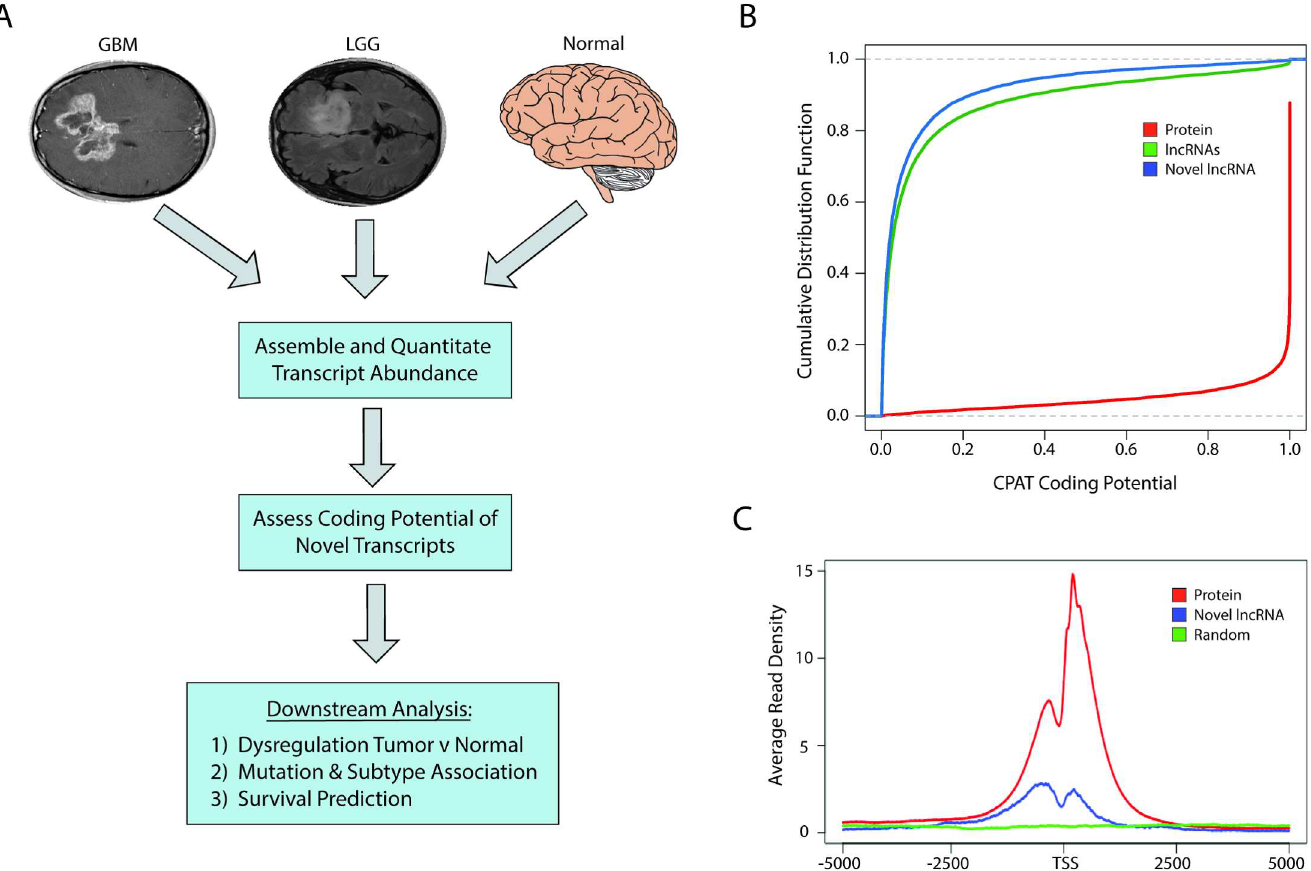
Fig 1. Identification of novel lncRNAs in glial tumors and normal brain RNA-seq samples. (A) Overview of analysispipelinefor identifying novel lncRNAsand determiningtheir associationswith clinicallyrelevant phenotypes. (B) Cumulativedistribution function plot of CPAT scores demonstrates that the majority of novel transcripts are predicted to not code for proteins (CPAT score < 0.5242). (C) Metageneplot of H3K4me3 ChIP-seq data from U87 cell samples shows enrichment in promoters of protein-coding genesand novel lncRNAs but not in a randomizedgenomiccontrol. GBM, glioblastoma multiforme; LGG, lower grade glioma;lncRNA, long noncoding RNA; RNA-seq,RNA sequencing.